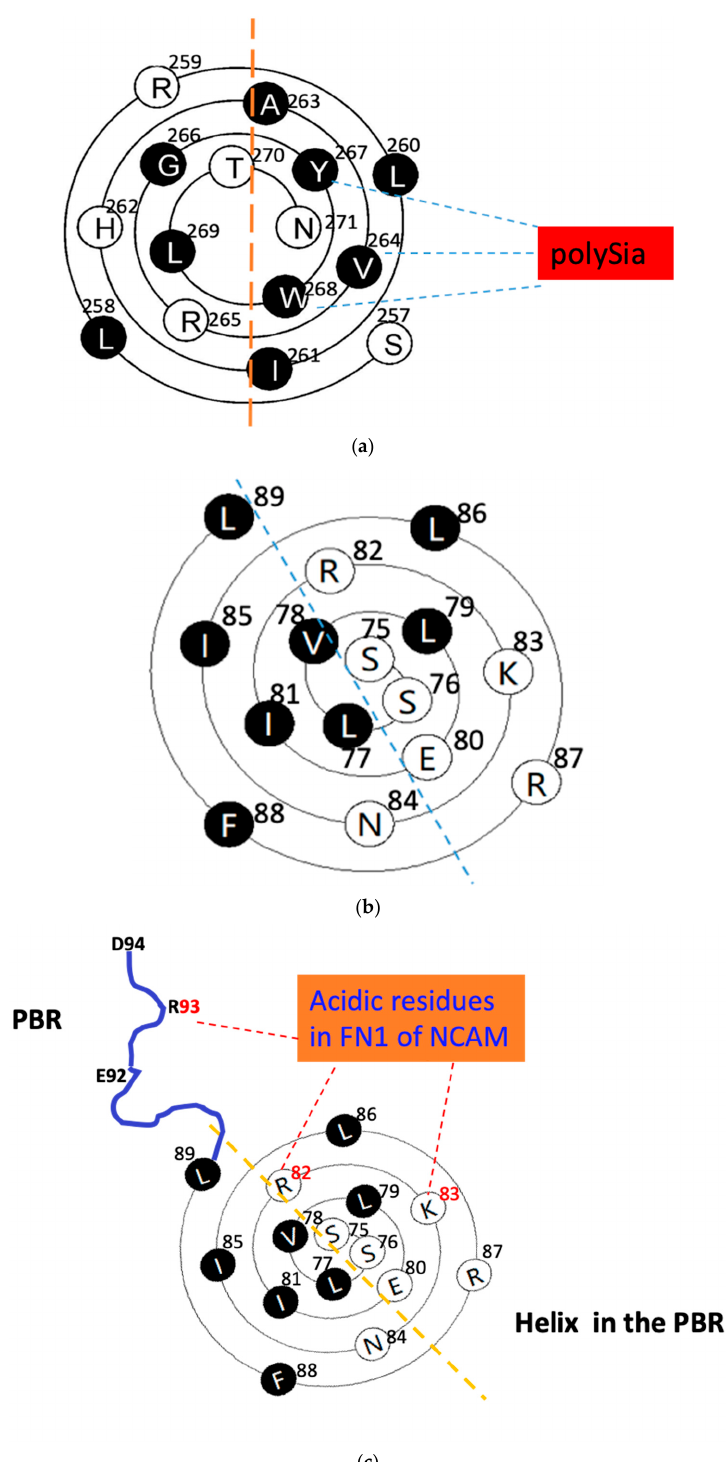
Figure 1. The predicted 3D backbone model of human ST8SiaIV was generated using Phyre2 sever [46] ( a ), the extracted PBR (blue) and PSTD (yellow) backbone motifs from the model ( a ) is shown in ( b ) and the surface model of the ST8Sia IV is displayed in ( c ). All basic residues are labeled in red. Above models were displayed using PyMol 2.5.